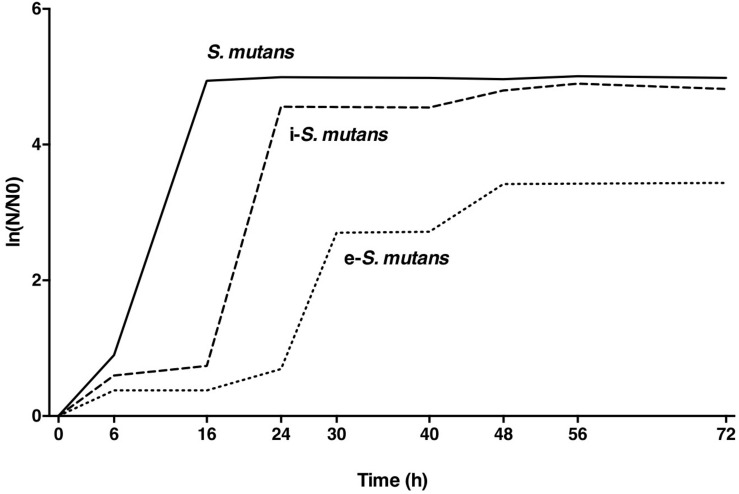
Representative growth curves of the intracellular (i-S. mutans), the extracellular (e-S. mutans) and the bacteria control (S. mutans), indicating a biphasic growth for e-S. mutans (n = 3).